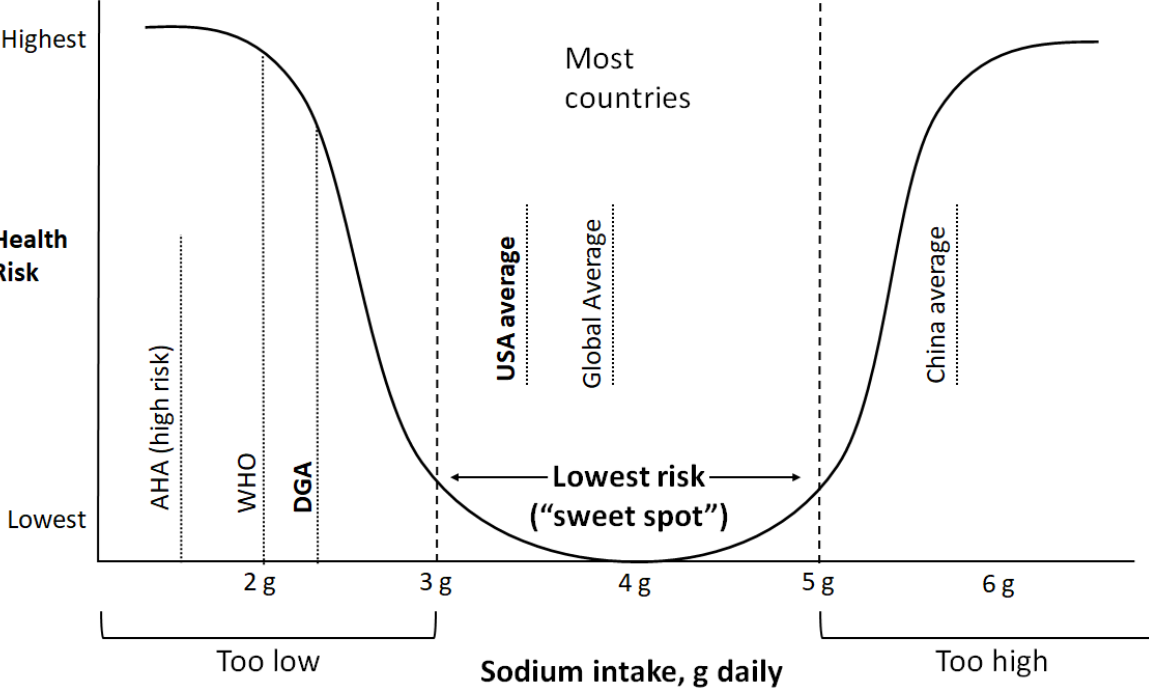
Figure 1. Conceptual diagram of health risk by sodium intake levels based on the current evidence. The lowest risk range (i.e., “sweet spot”) for sodium intake is at ~3 to 5 g/day, with both lower and higher levels of intake associated with higher risk of cardiovascular disease or death. The Dietary Guidelines for Americans (DGA) recommendation for sodium corresponds with a higher risk of adverse health outcomes.